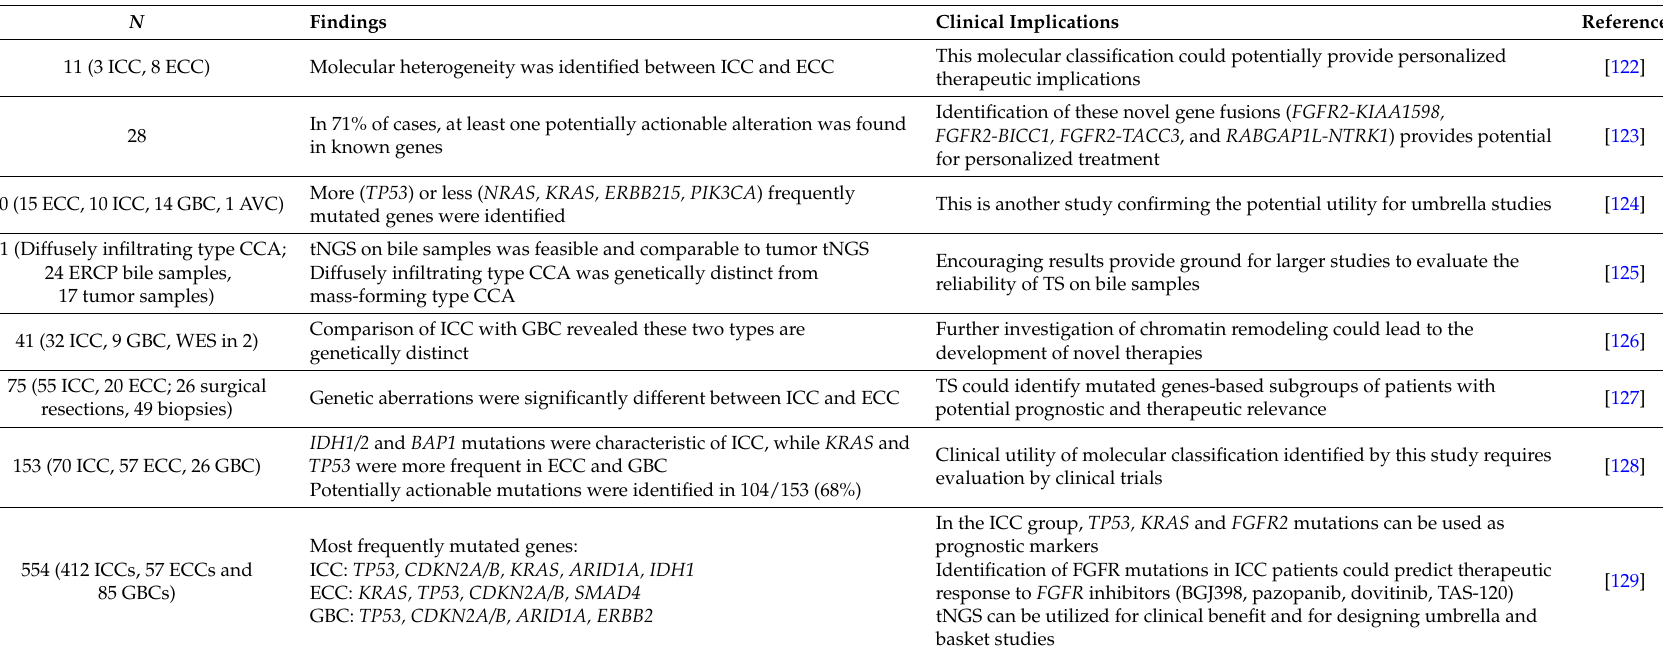
Table 6. Targeted next-generation sequencing studies on biliary tract